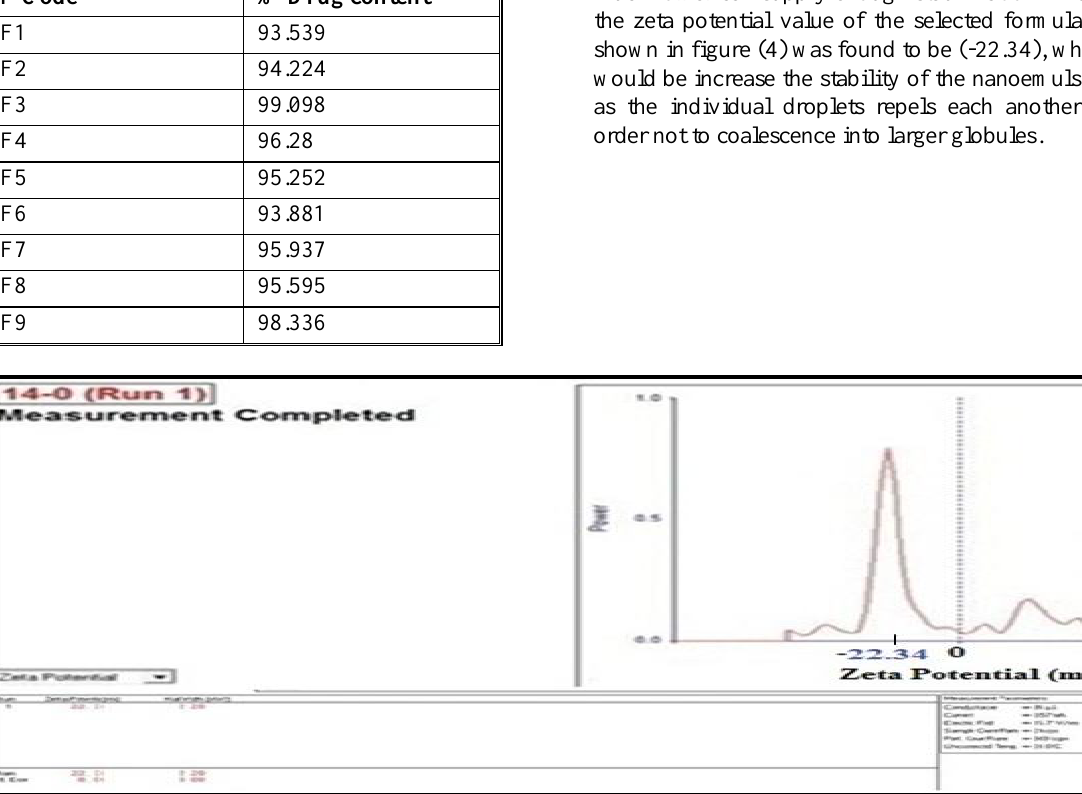
In vitro drug dissolution study Higher and faster the absorption, and hence quicker and greater the drug action can be obtained by smaller the particle size of a drug in the dosage forms (30) . The release of felodipine from the formula that contain tween 80 as surfactant (F3) was higher than that contain tween 60 (F8) which could be explained by the smaller droplet size of formulas containing tween 80 as compared to that formulas which contain tween 60 leading to greater rate of dissolution. While the release of formulas that contain tween 80 (F2, F4) is greater than formulas contain tween 60 (F7, F6) due to the higher HLB value of tween 80 which is 15 enhanced the continuous distribution and solubilization of the incorporated lipophilic drug within the system. (31) as shown in figures